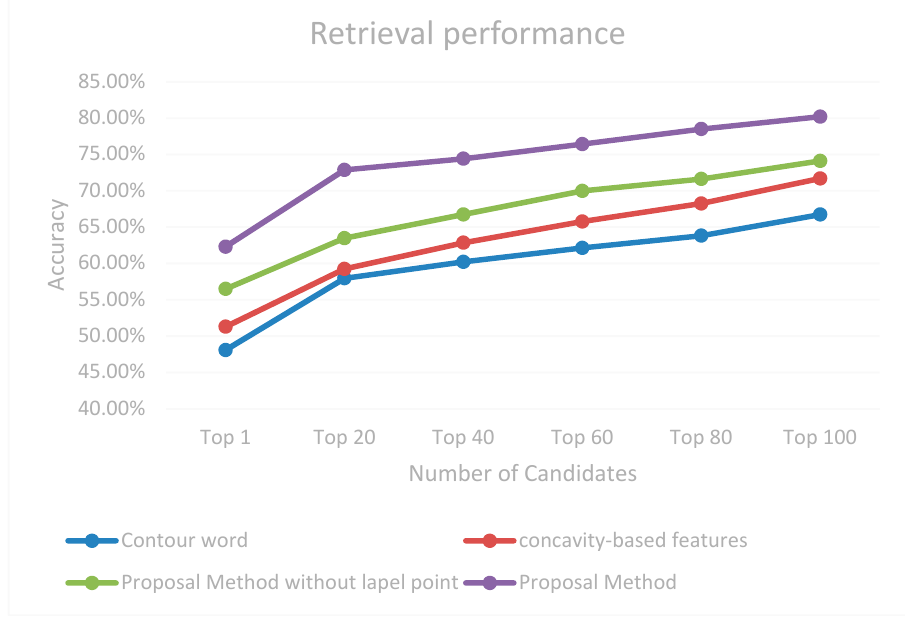
Figure 28. The performance of localization.